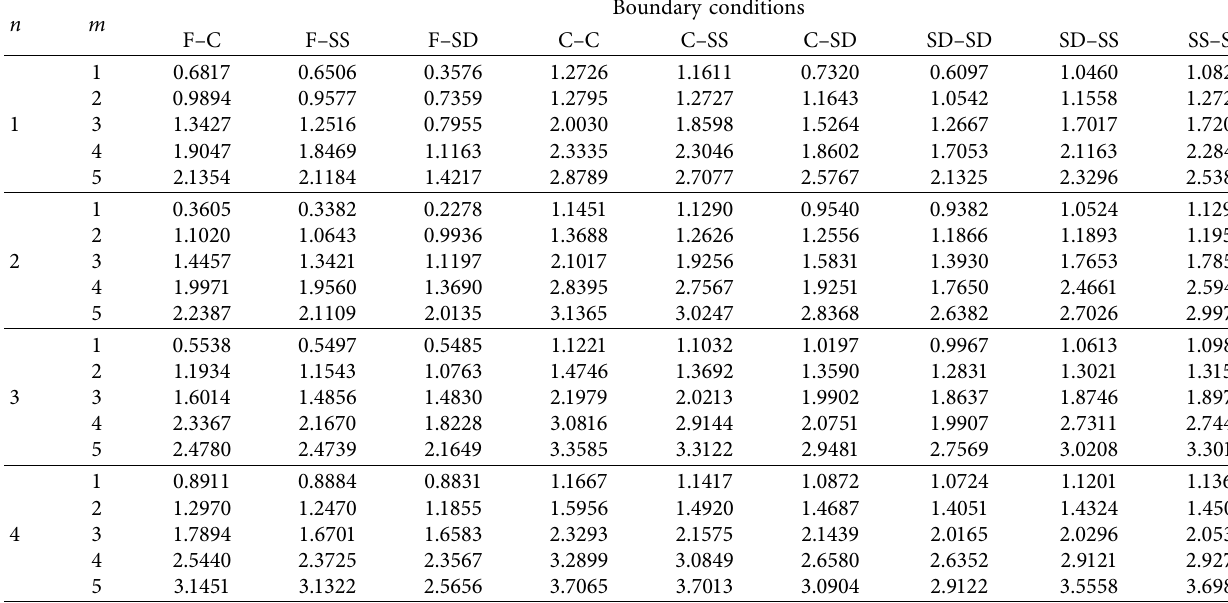
� π /6, φ � π /2, h � 0.06 m, and R � 1m). 0 1